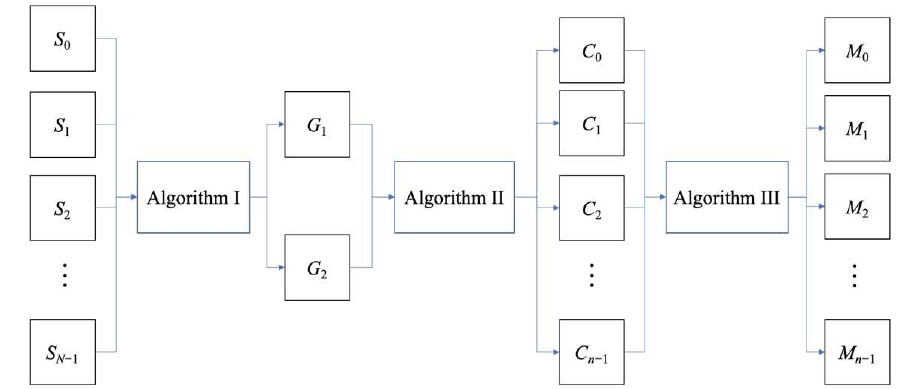
Figure 1. The model of the encryption process of the proposed scheme.